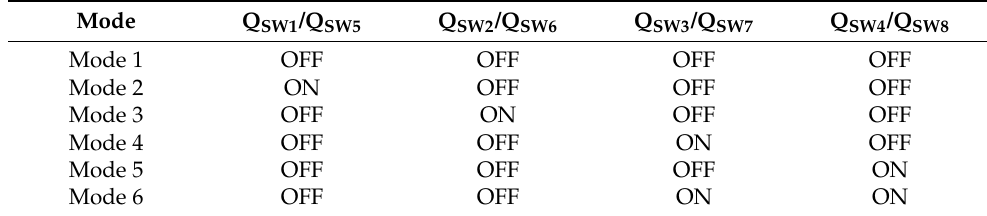
Table 1. Six modes of sub-bands for the switched